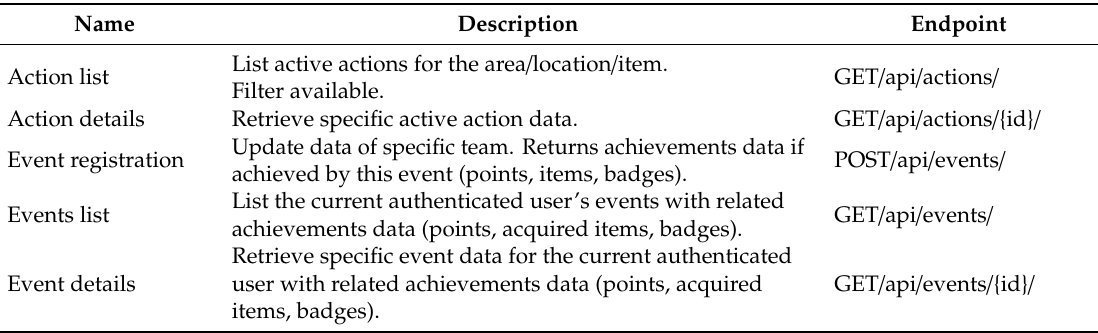
Table 6. Visitor activity tracking